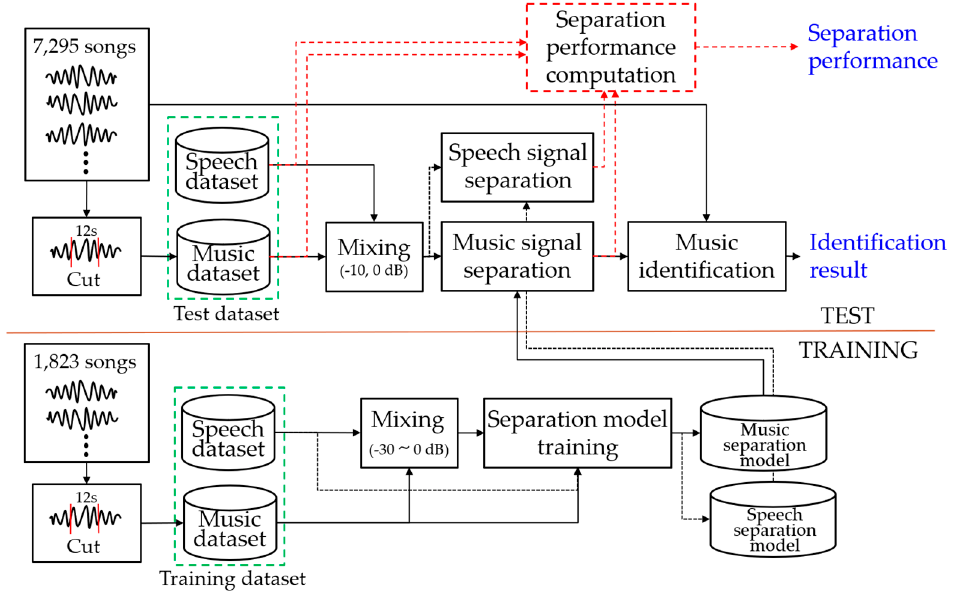
Figure 9. Overall structure of music identification experiment.